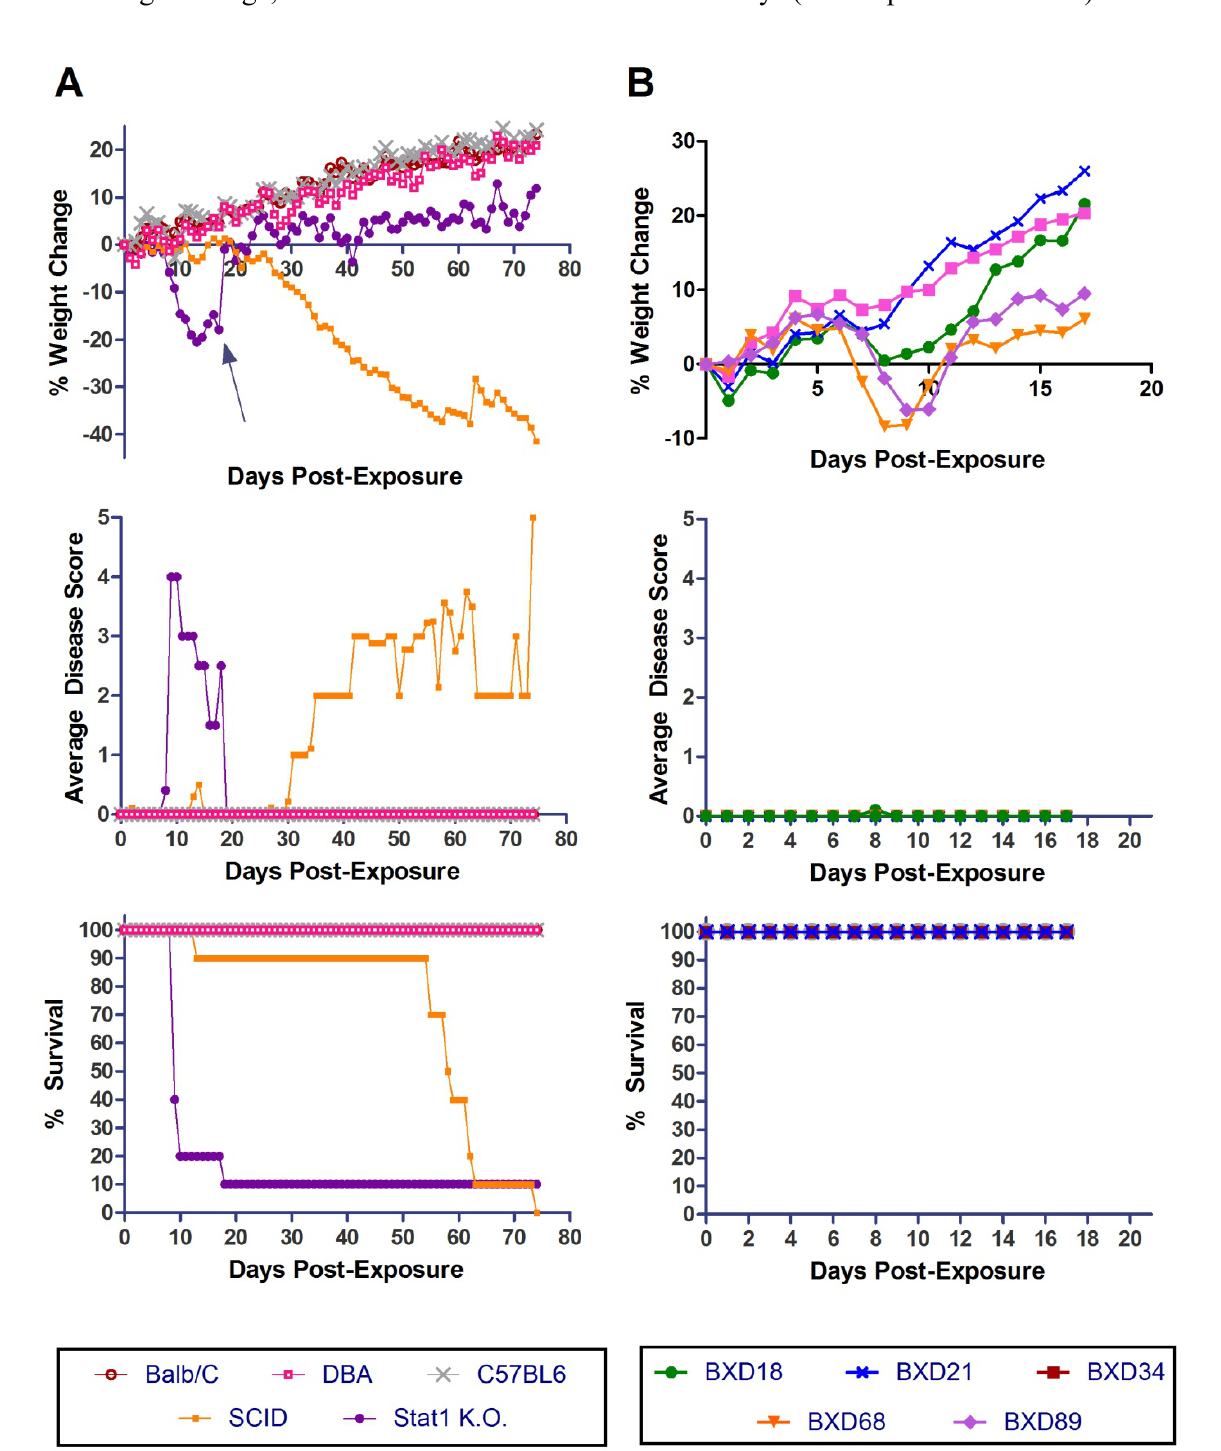
Figure 6. Exposure of mouse strains to aerosolized WT-EBOV. ( a ) BALB/c, DBA/2, C57BL/6, SCID and Stat1 KO mice and ( b ) BXD18, BXD21, BXD34, and BXD68 and BXD89 mice were exposed to non-adapted EBOV by the aerosol route and monitored for % weight change, disease score and survival for 17 – 80 days (n = 10 per mouse